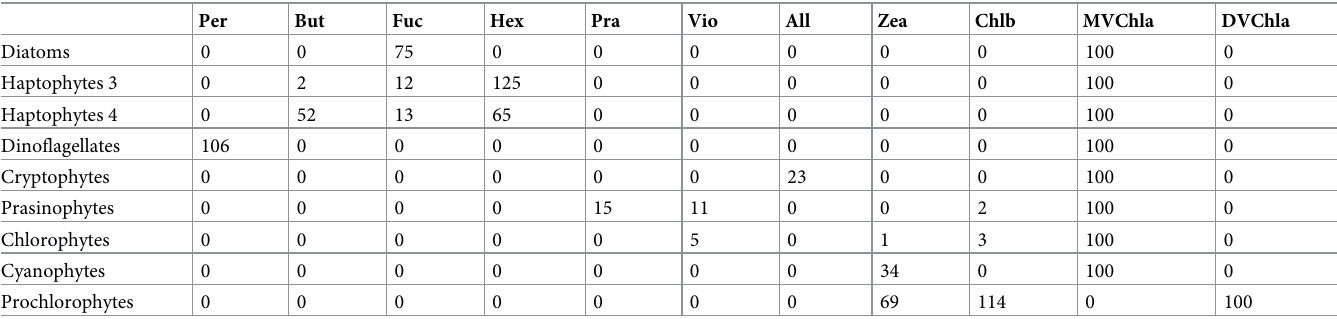
Per: peridinin; But: 19’-butanoyloxyfucoxanthin; Fuc: fucoxanthin; Hex: 19’-hexanoyloxyfucoxanthi; Pra: prasinoxanthin; Vio: violaxanthin; All: alloxanthin; Zea: zeaxanthin; Chlb: chlorophyll b ; MVChla: monovinyl chlorophyll a ; and DVChla: divinyl chlorophyll a .